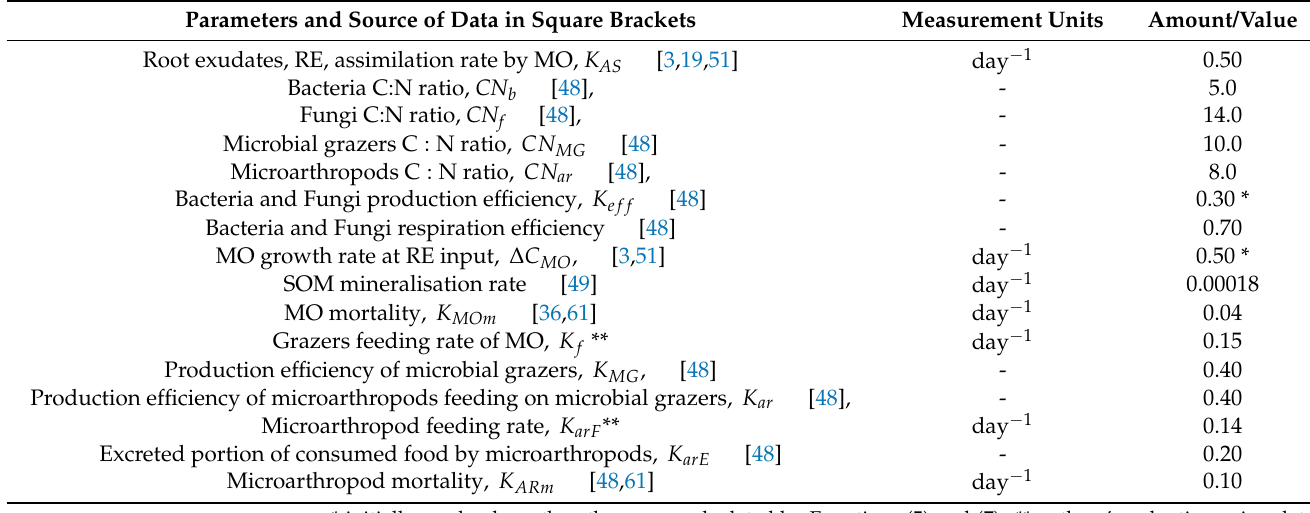
Table 2. Parameters of the